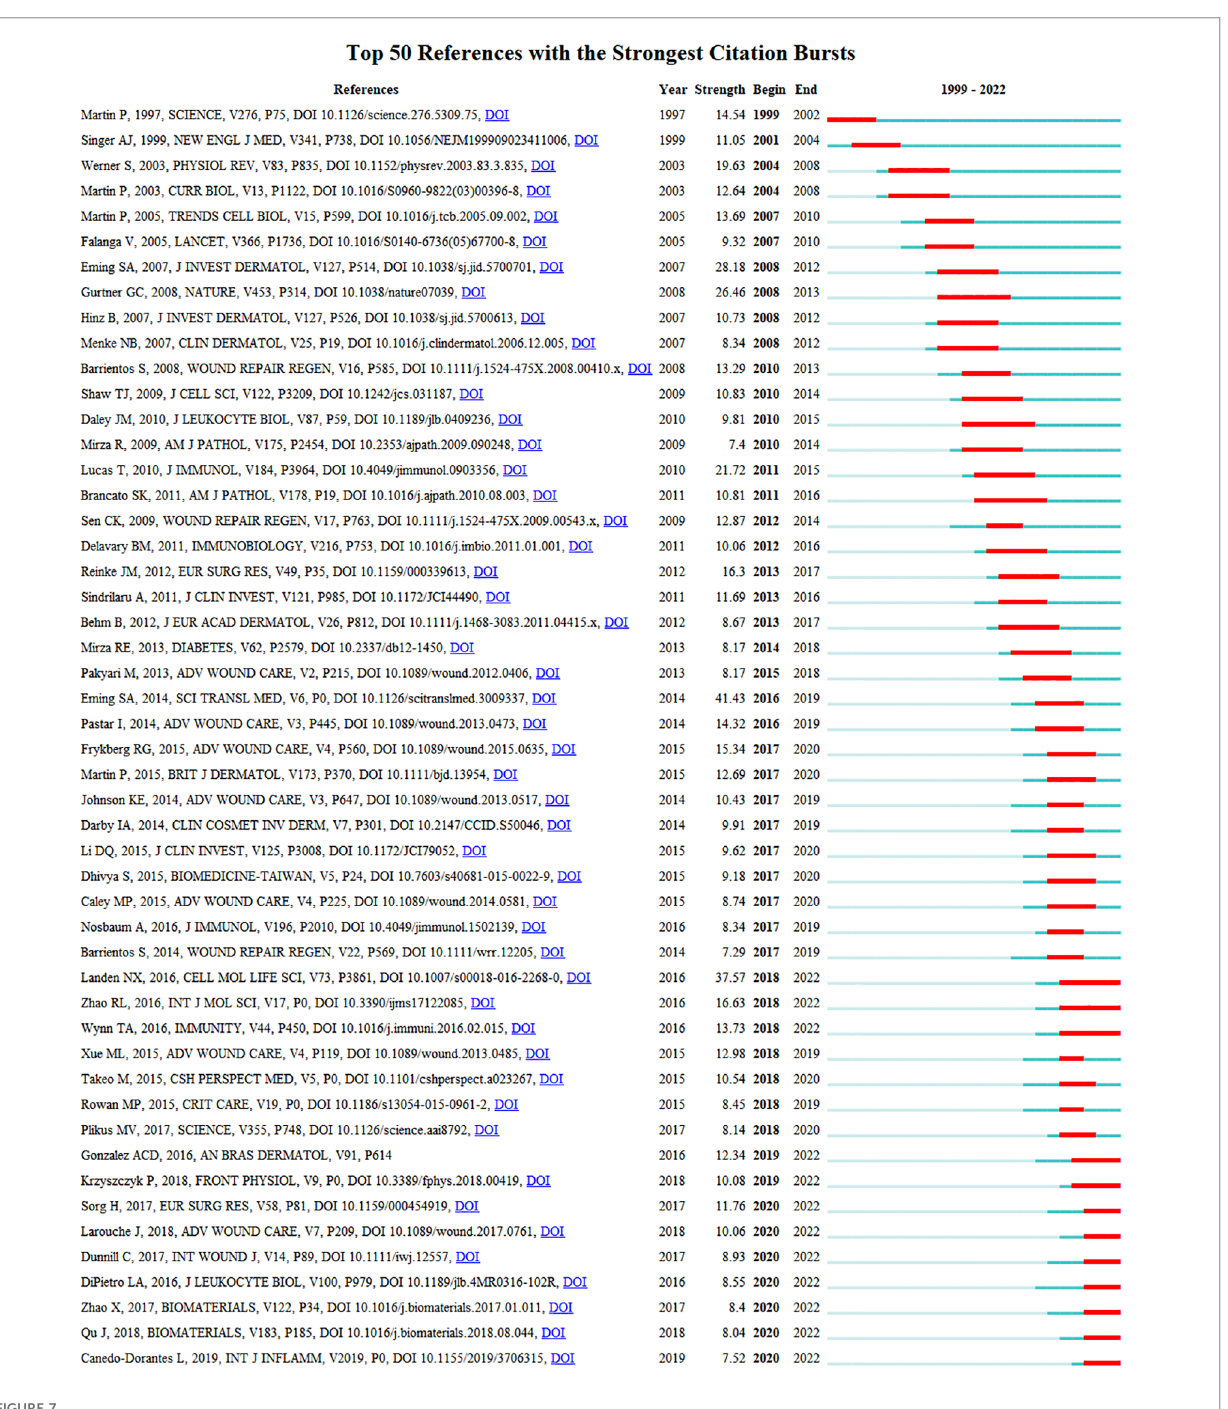
FIGURE 7 CiteSpace visualization map of top 50 references with the strongest citation bursts. A citation burst is when the citation situation of a paper changes dramatically in a short period of time. The red line indicates the duration of the outbreak, and the intensity of the outbreak indicates the impact of the article. The citation burst is analyzed with